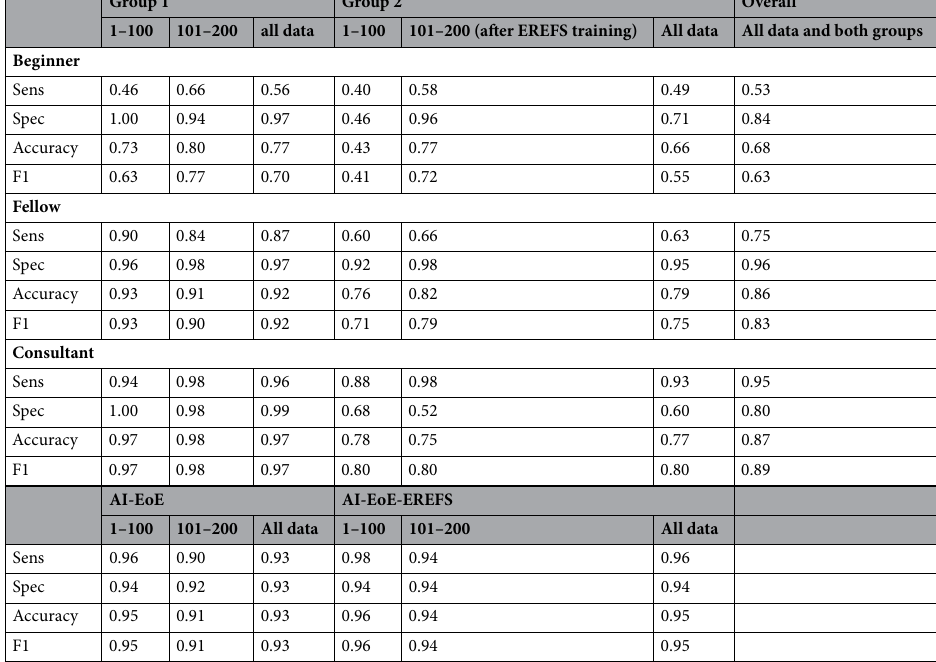
Table 2. Performance of human endoscopists and AI- models in diagnosing eosinophilic esophagitis on endoscopic white light images. Group 1 endoscopists relied on their clinical experience, while Group 2 was educated on the EREFS criteria for the second batch of images. AI-EoE was trained with binary classification, while AI-EoE-EREFS was trained additionally using auxiliary branches generated from the EREFS